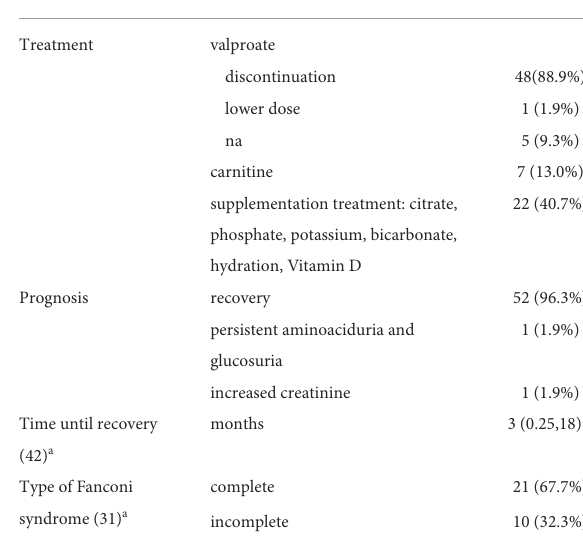
TABLE 4 Urinalysis, renal biopsy, and ultrasonography of the 54 included patients.